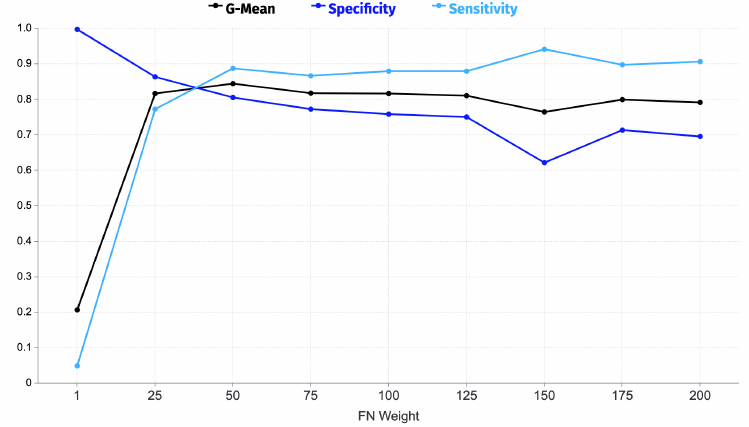
Figure 9. The effects of FN prediction weight on g-mean, specificity, and sensitivity when using the cost-sensitive MHOANN with the CSO for the dataset of Taiwanese companies.